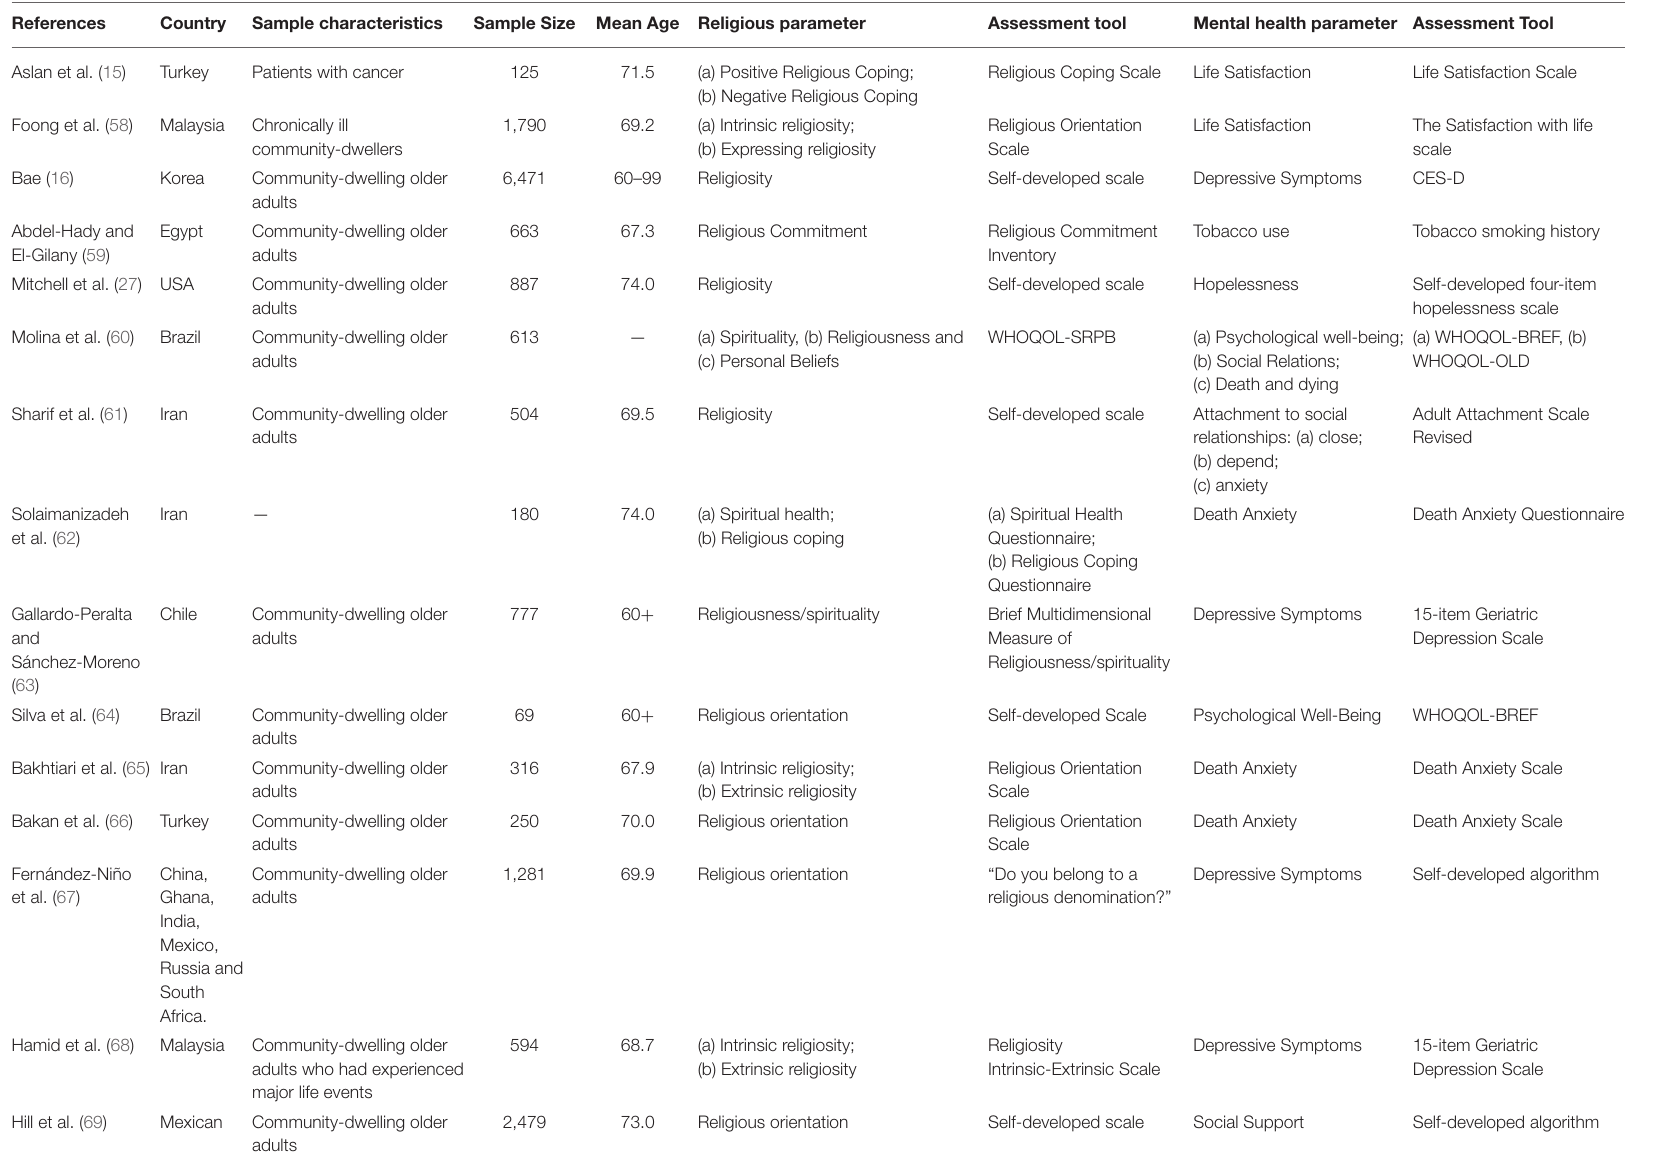
TABLE 1 | Main characteristics of the cross-sectional and case-control studies that investigated the association between religious activities and mental